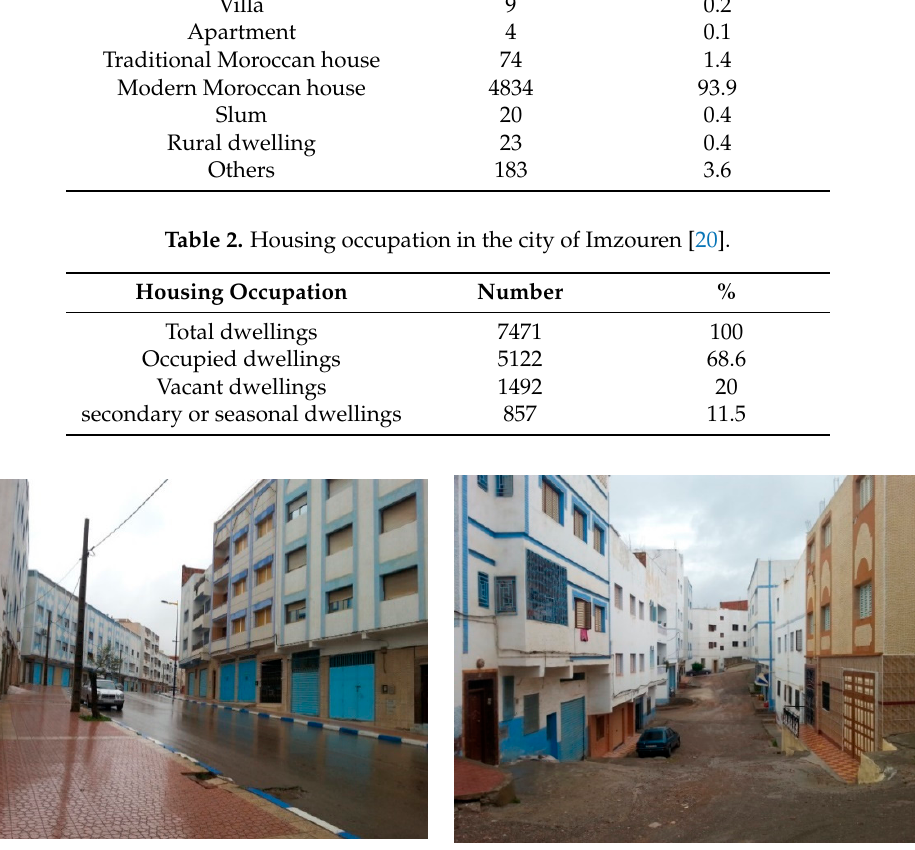
Figure 4. Modern Moroccan houses in the city of Imzouren.